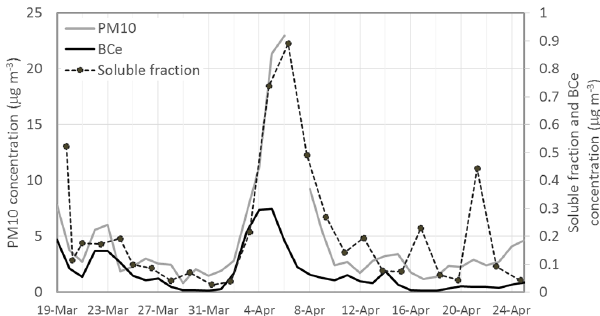
Figure 2. Time series of PM 10 mass concentration, integrated from size distribution measurements (size range: 0.3–10µm); black car- bon equivalent (BC e ) concentrations; and total concentration of par- ticle soluble